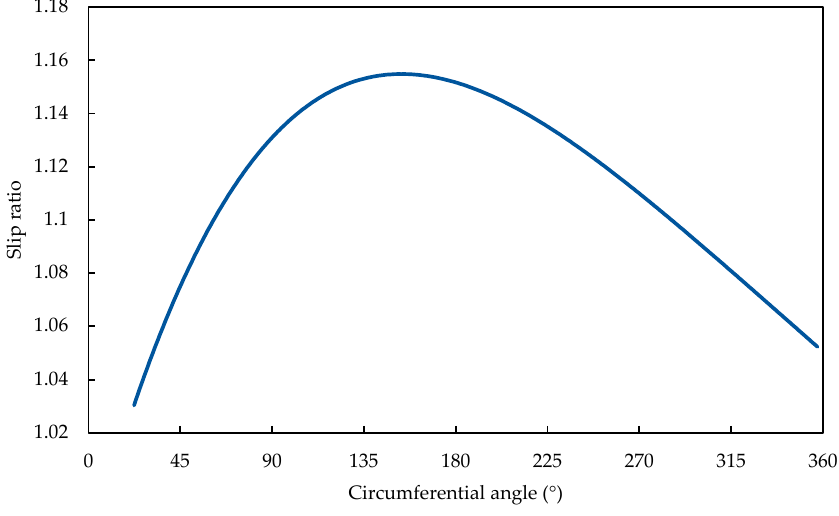
Figure 7. Slip velocity ratio with different circumferential angles.